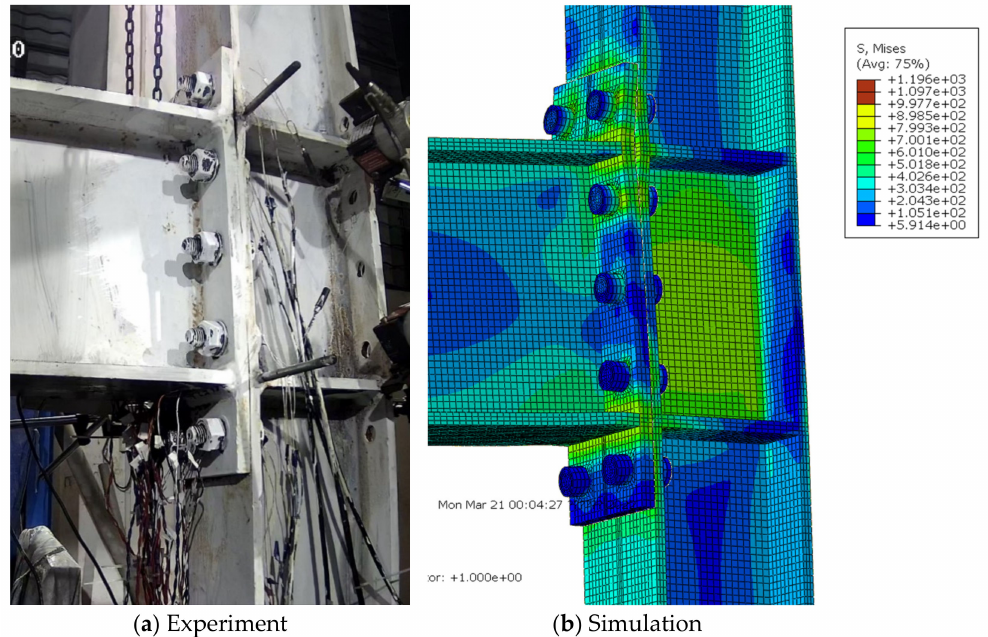
Figure 10. Comparison of experimental and simulated deformation modes in specimen S5 at the second positive peak of 5% loading